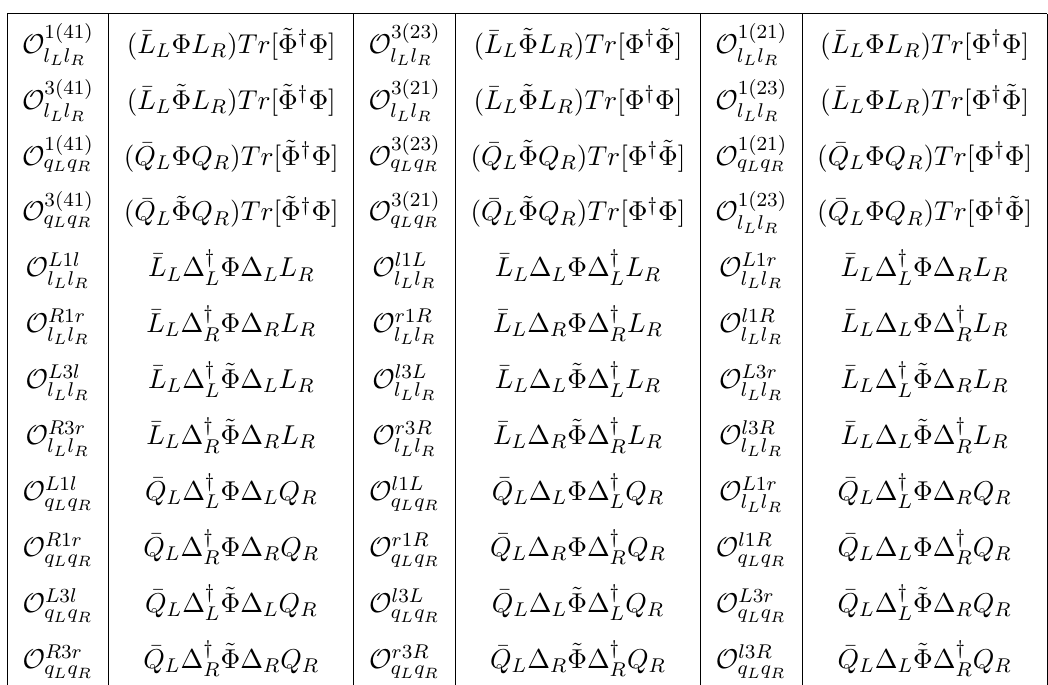
Table 22. MLRSM: 2 (cid:30) 3 [36 2 = 72] (Dirac type) class of operators. Each of these operators (cid:2) also has a distinct Hermitian Conjugate.